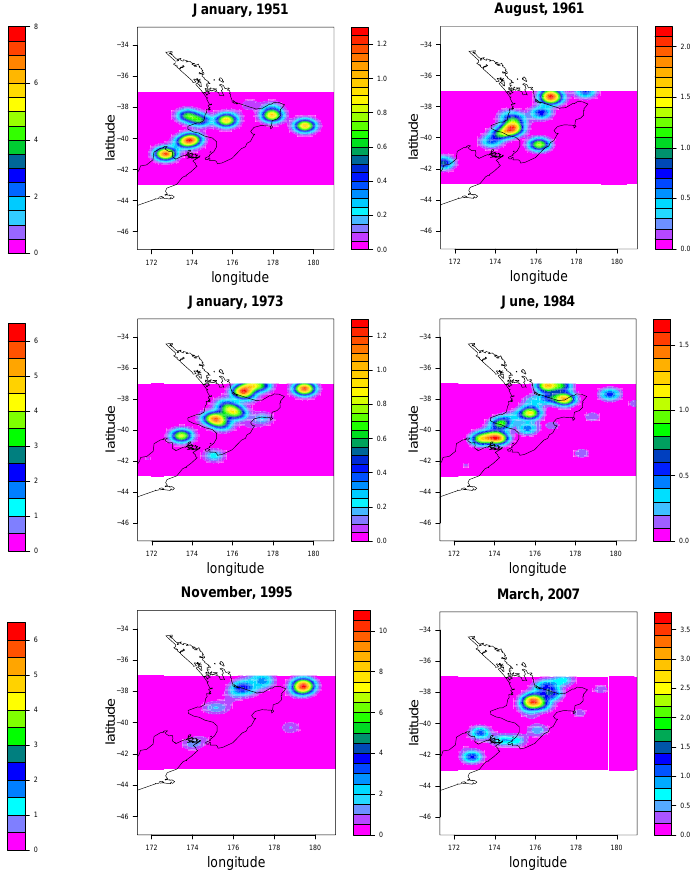
Fig. 7. Space-time-magnitude smoothed conditional intensity func- tion for M = 5 . 5 around a fixed point at six different times. cays after a short period; this clustered activity comes before the second main event, followed by a decreasing activity pe- riod. A big rate of intensity is observed also after the third main event, with increasing values followed by a decreasing clustering